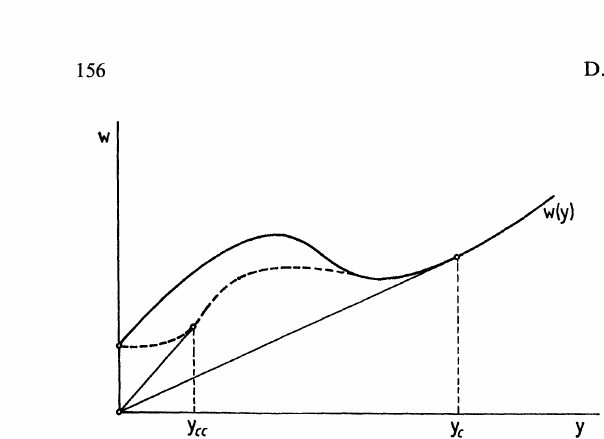
FIGURE 8 A discontinuous change of the convexity index from yc to Ycc due to a deformation (dashed) of w(y).